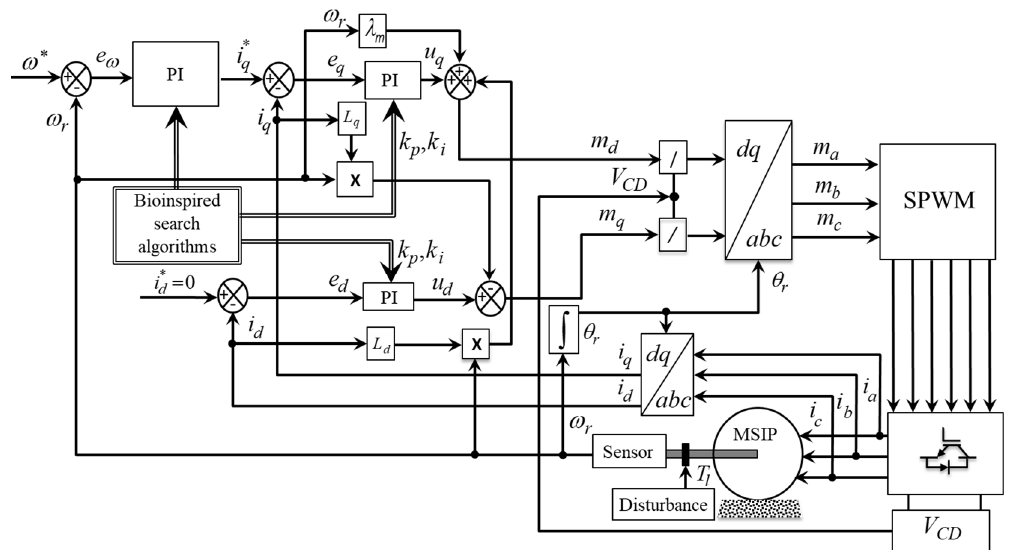
Figure 1. Speed control scheme of a PMSM.